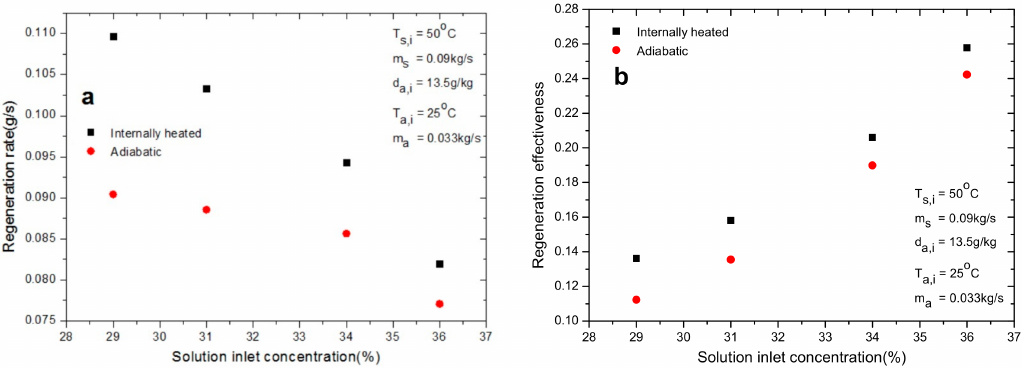
Figure 12. Effect of solution concentration on regeneration performance: ( a ) regeneration rate; ( b ) regeneration